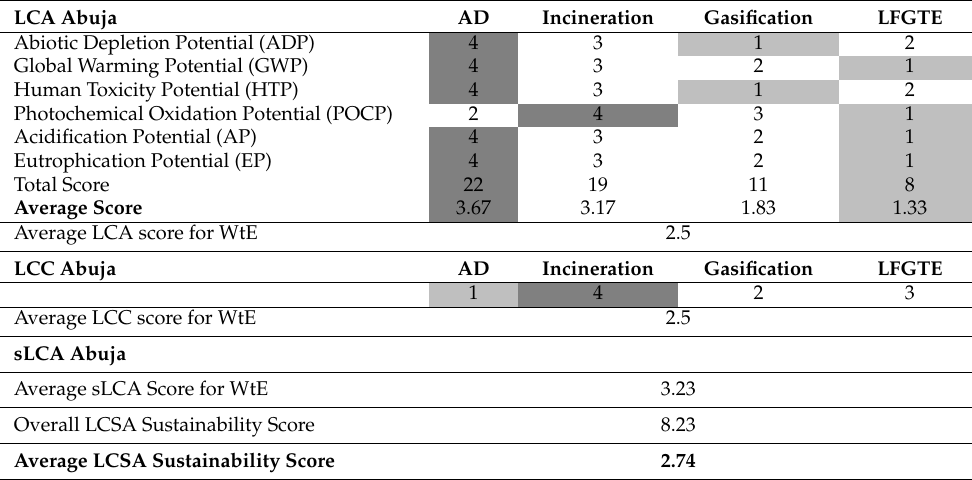
Table 1. Overall LCSA Outcomes of WtE in Abuja using the Scoring and Ranking Approach. LCA Abuja